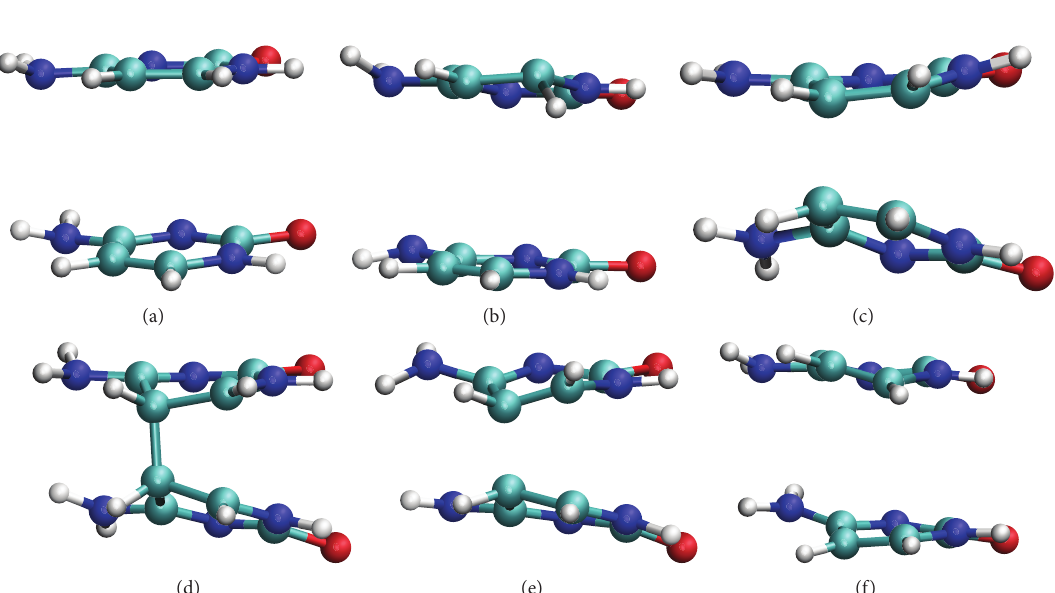
Figure 2: Snapshots taken from the simulation of two stacked cytosine molecules at (a) 0, (b) 244, (c) 923, (d) 964, (e) 993, and (f) 1082